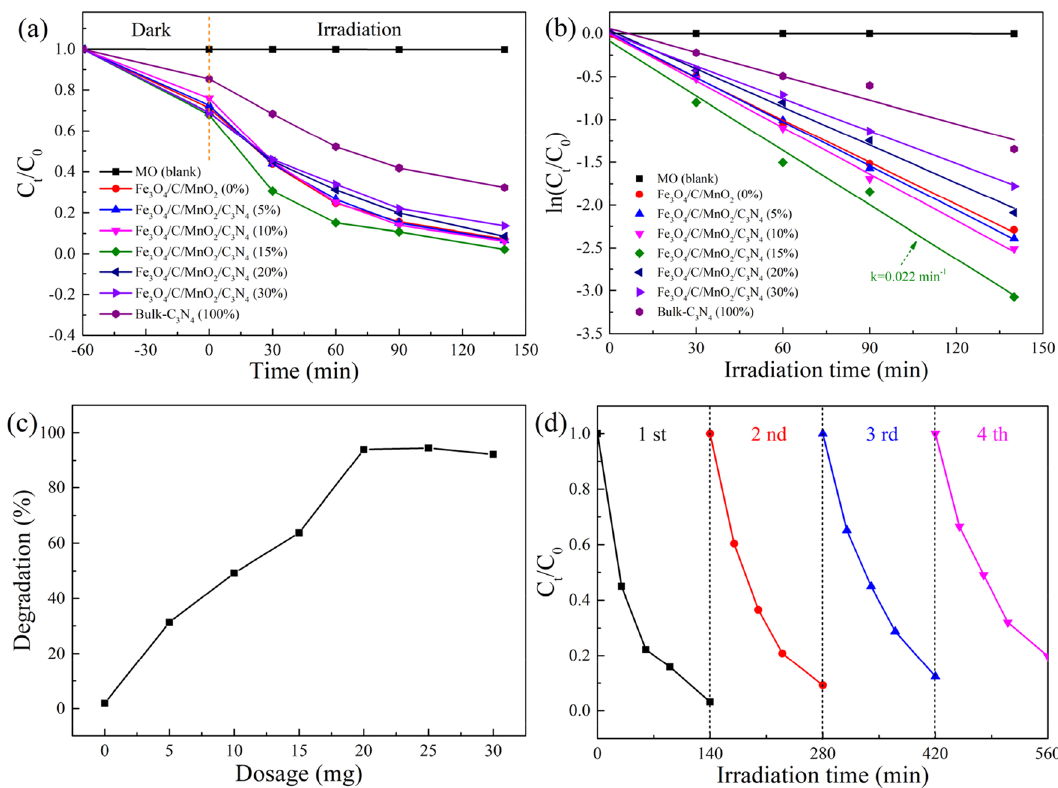
Figure 7. Effect of the amount of C 3 N 4 on the degradation of MO ( a , b ), effect of the amount of Fe 3 O 4 /C/ MnO 2 /C 3 N 4 photocatalyst on the degradation of MO ( c ), cyclic test of MO degradation of Fe 3 O 4 /C/MnO 2 /C 3 N 4 photocatalyst ( d ). Reaction conditions: [MO] = 65 mL, 10 mg/L, [light] = 400 W metal halide lamp, T = 25 °C, t = 140 min. For ( a , b , d ), [photocatalyst] = 20 mg.